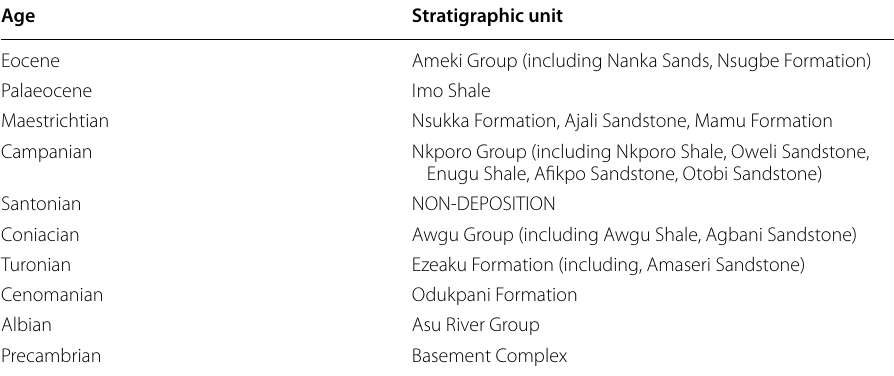
Table 1 Stratigraphy of the Anambra